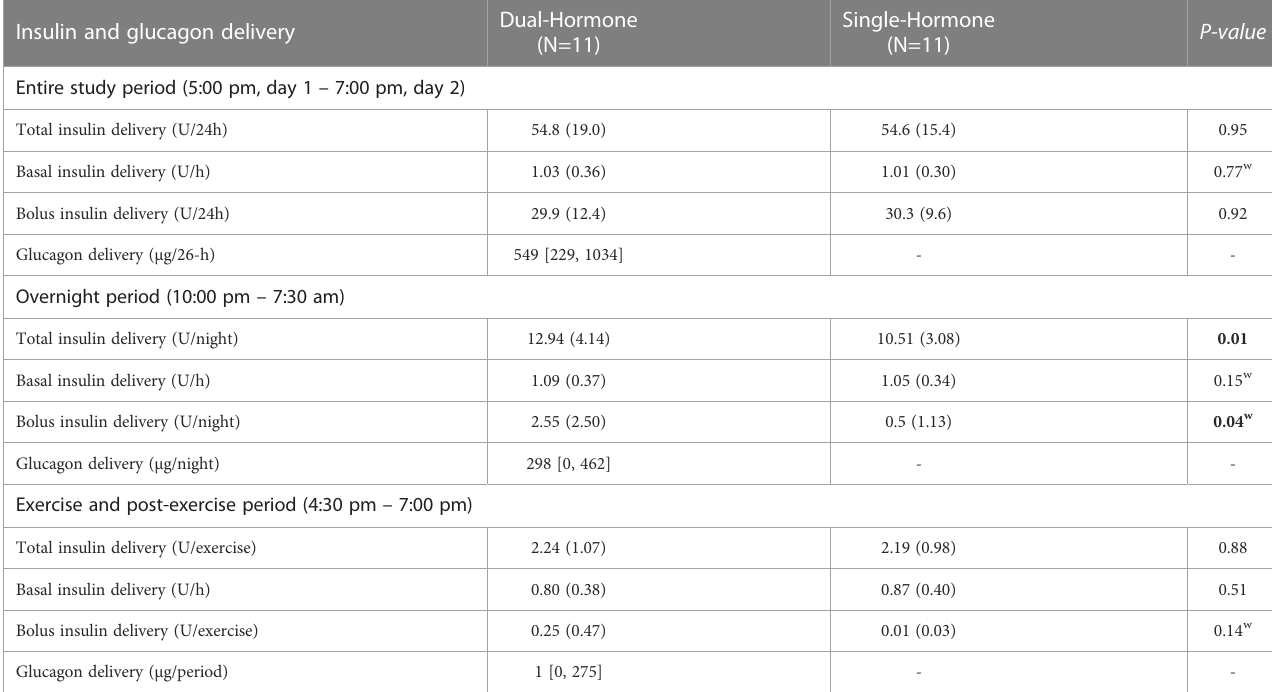
TABLE 3 Study medication administration. Insulin measures are reported as mean (SD) and glucagon as median [IQR].